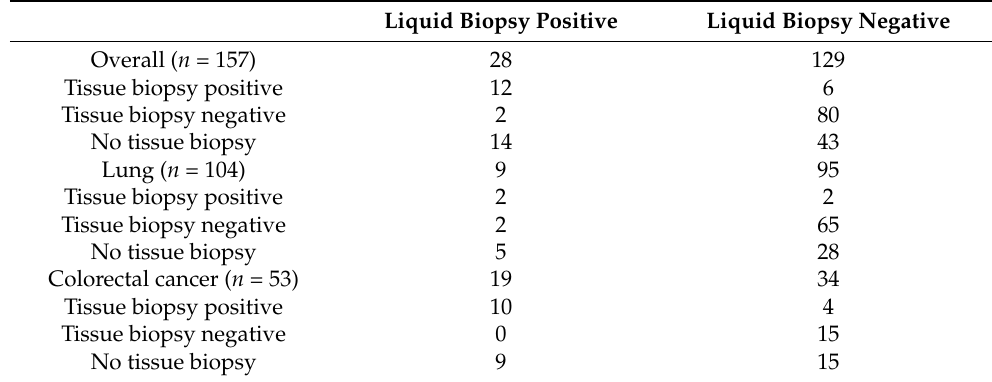
Table 2. Lung and colorectal cancer patients under investigation for ctDNA liquid biopsy test and treatment selection.